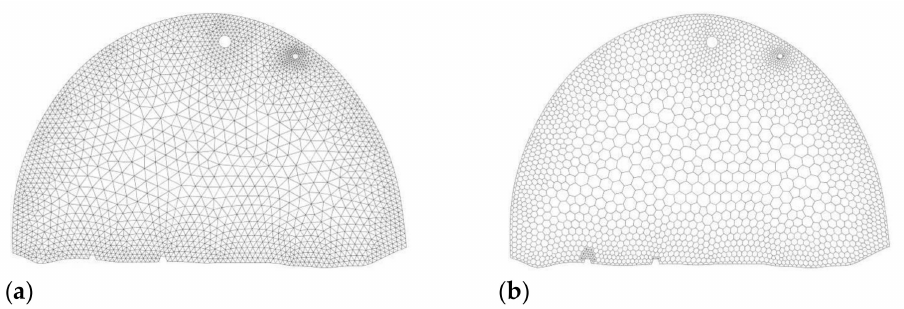
Figure 5. Computational grid at the inlet cross-section: ( a ) tetrahedral grid, ( b ) after conversion to a polyhedral grid.